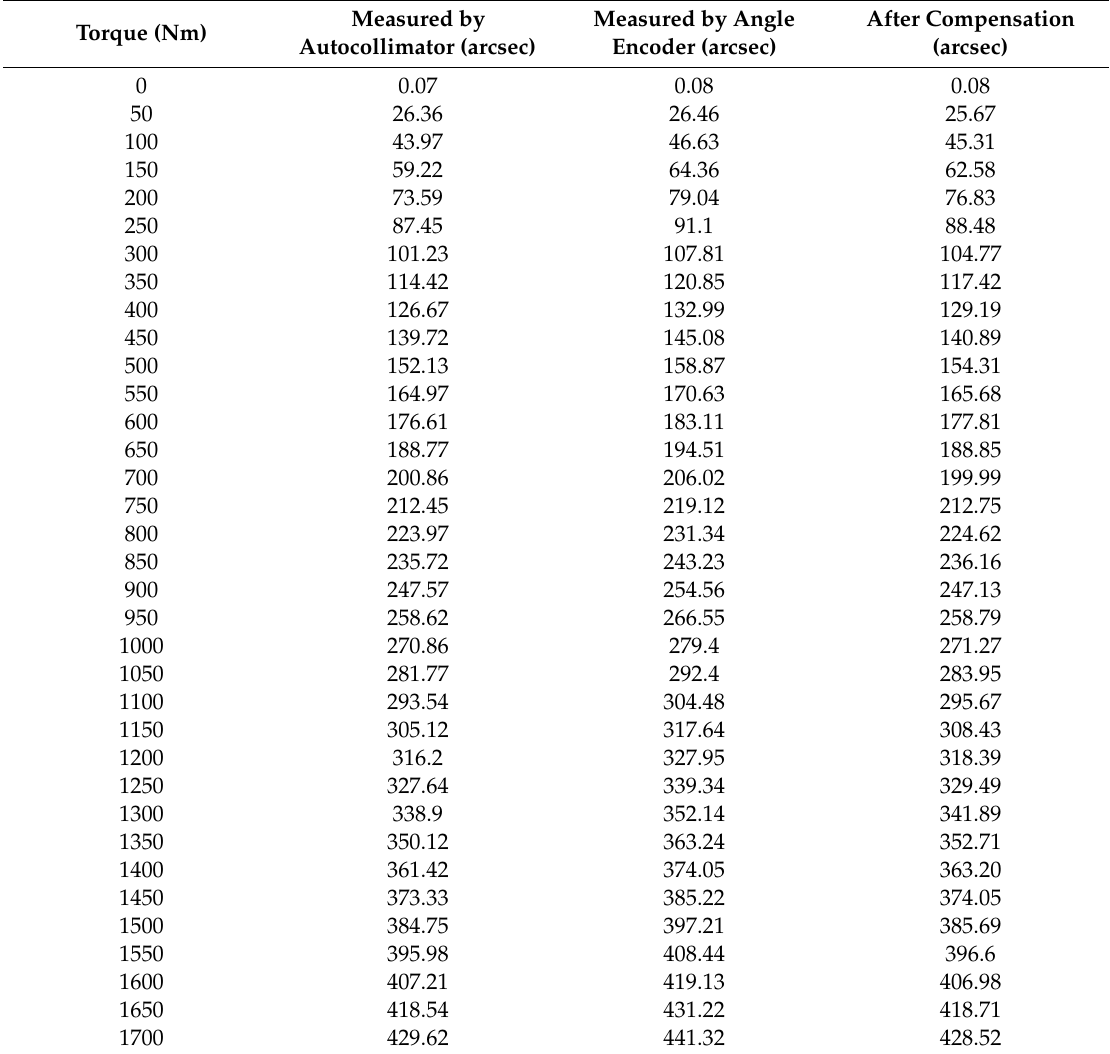
Table 4. Measurement data and compensation